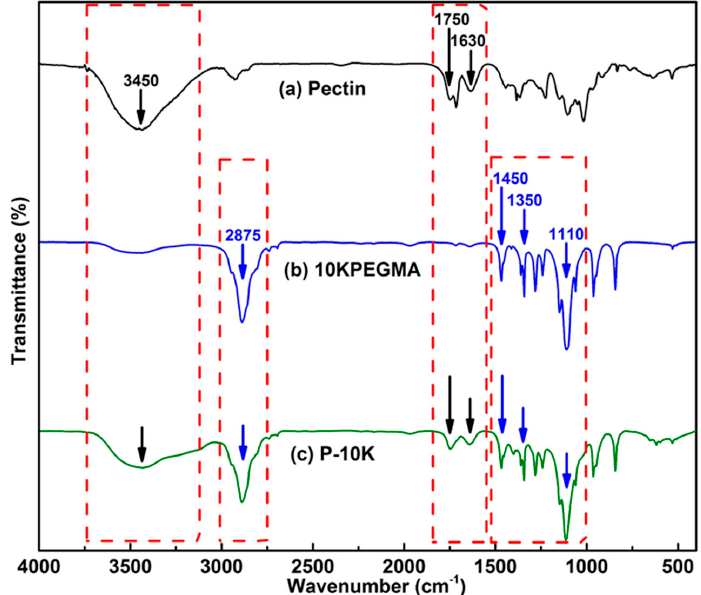
Figure 3. FTIR spectra of the precursors (pectin and 10KPEGMA) and of copolymer P-10K.